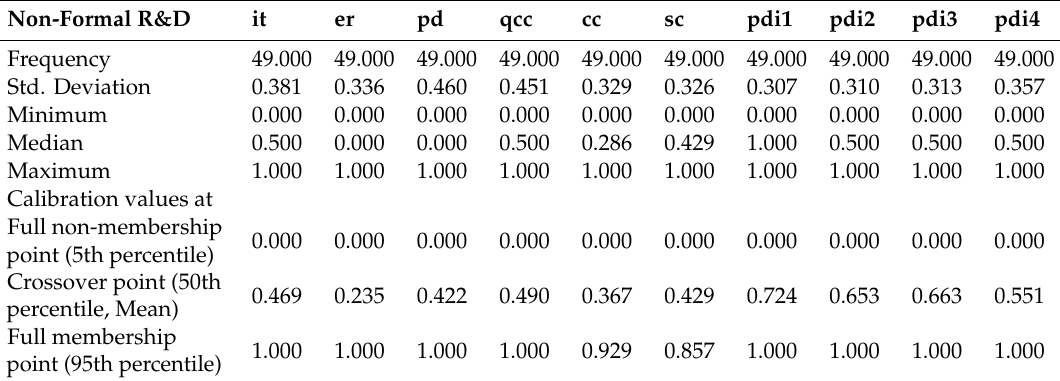
Table 3. Causal conditions and outcome calibration in non-formal R&D